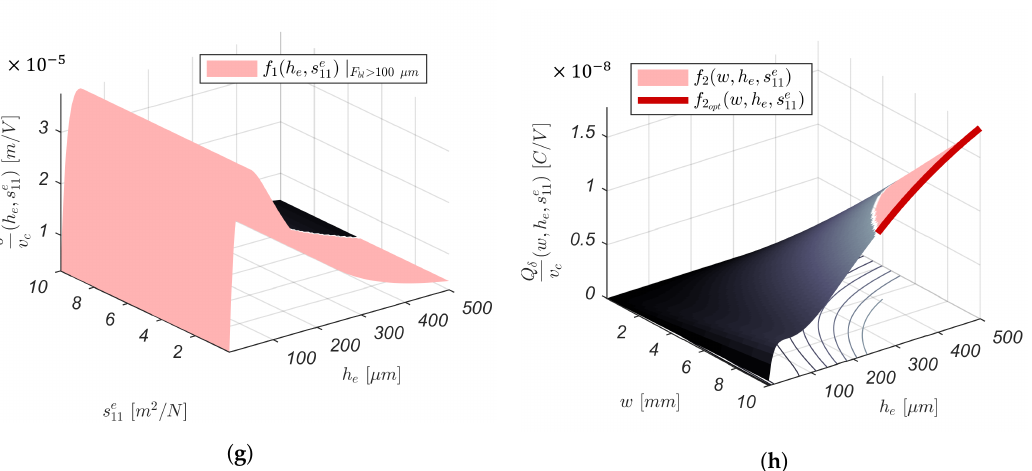
Figure 9. Influence of varying PEA’s width w and elastic layer thickness h e : measured, numerical, and analytical results. ( a ) Photo of the experimental setup. ( b ) Schematic block diagram of the experiment. ( c ) Measured PEA’s tip displacement due to the application of a step input voltage: PEA’s actuation. ( d ) Measured strain-induced charges due to the application of a step input voltage: PEA’s sensor sensitivity. ( e ) Numerical evaluation of the piezoelectric actuation. ( f ) Numerical evaluation of the PEA’s sensor sensitivity. ( g ) Analytical evaluation of the piezoelectric actuation with the application of the geometric constraint (Equation (11)) to guarantee the minimal blocking force, F bl > 100 µ